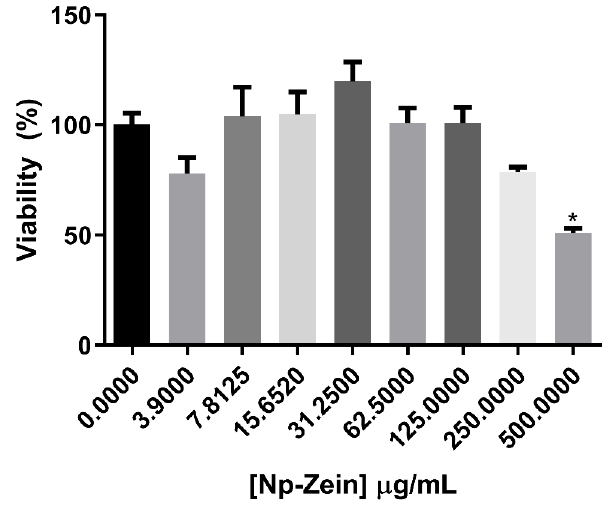
Figure 1. Chemical structure of mesalazine ( A ) and zein ( B ).